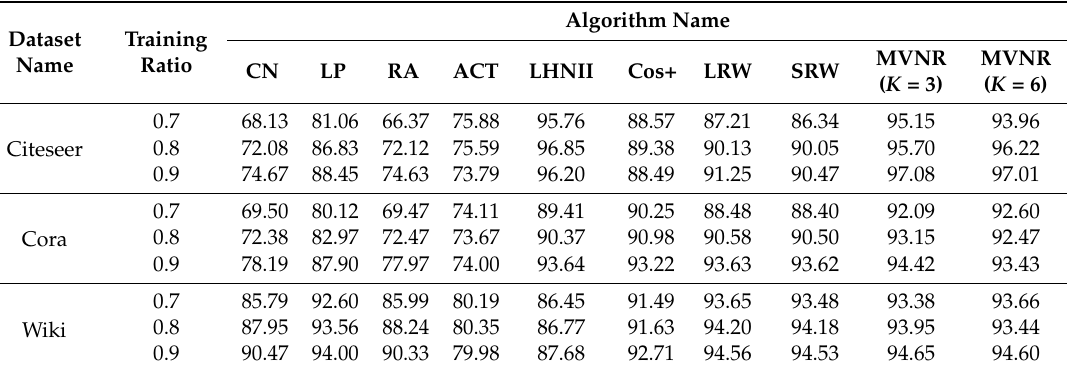
Table 6. Link prediction performance results on Citeseer